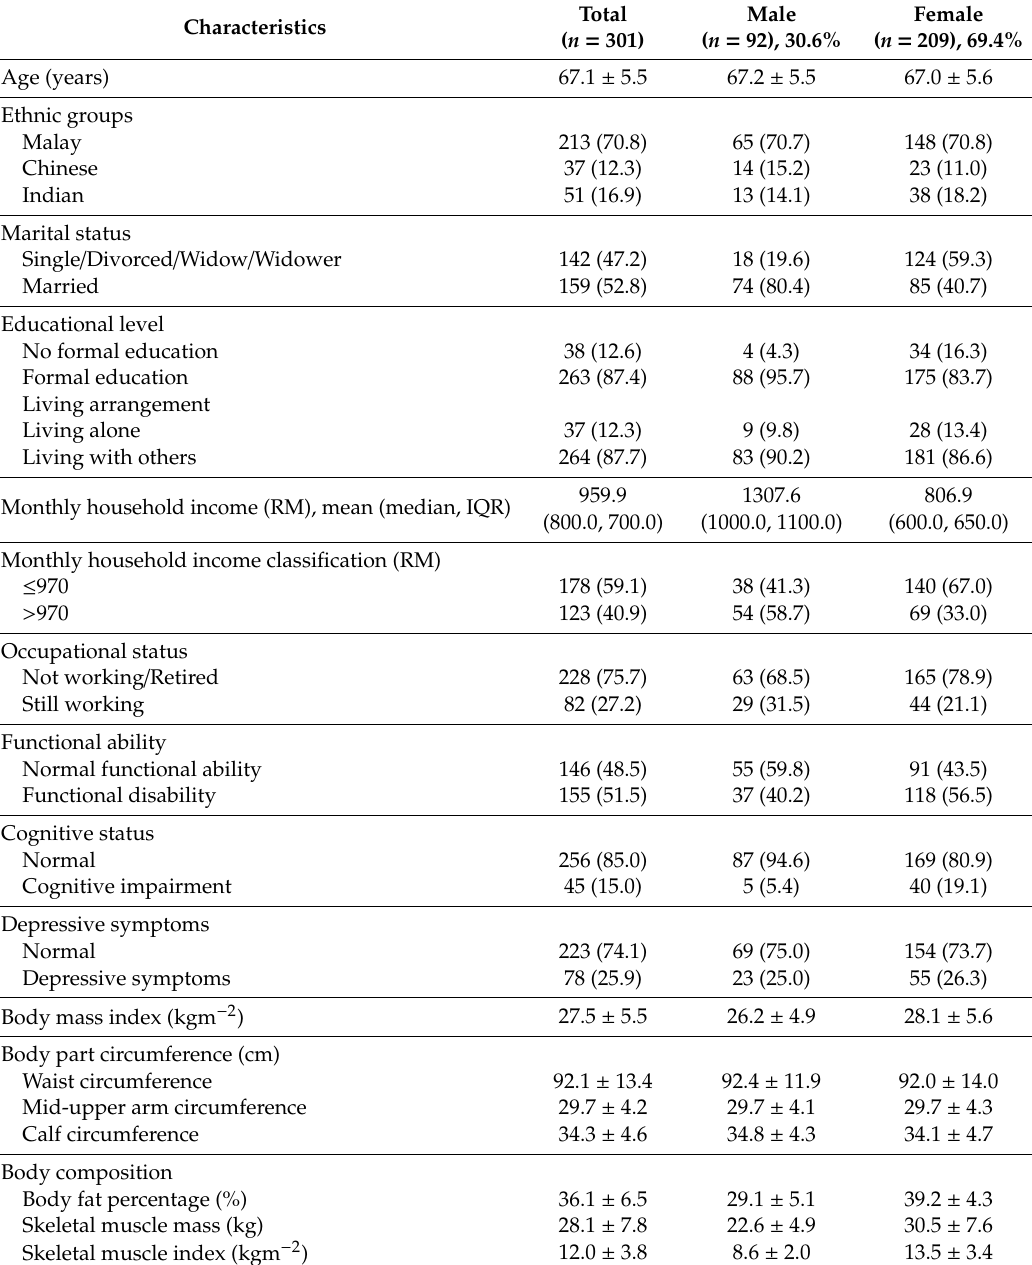
Table 1. Sociodemographic characteristics of subjects ( n =